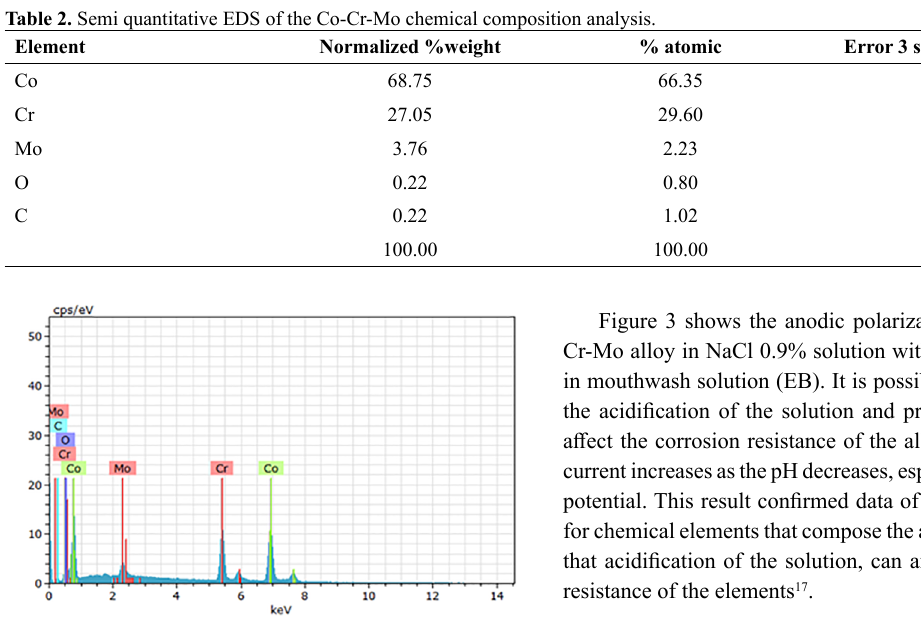
Table 3. Electrochemical parameters measured from the anodic polarization curves. Electrolyte OCP